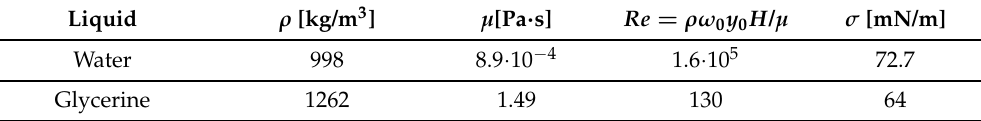
Table 1. Physical properties and characteristic Reynolds number of the two fluids, water and glycerine, used in the